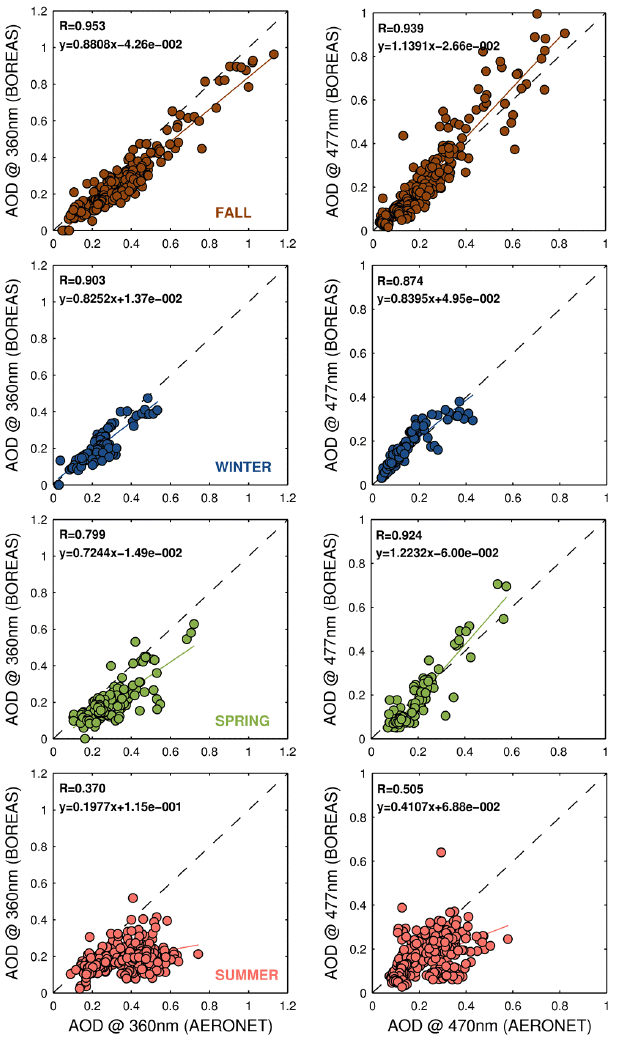
Figure 9. AOD scatterplots with their associated regression coeffi- cients for the fall (brown), winter (blue), spring (green), and sum- mer (red) seasons, illustrating the linear relationship of BOREAS AOD (obtained from BOKU MAX-DOAS, B; see Fig. 1) vs. AERONET AOD (obtained from sun photometer, B; see Fig. 1) in the UV (left panels) and visible (right panels) channels. Data of cloud-free days as defined in Sect. 2.2.4 between 1 September 2017 and 31 August 2019 are included.